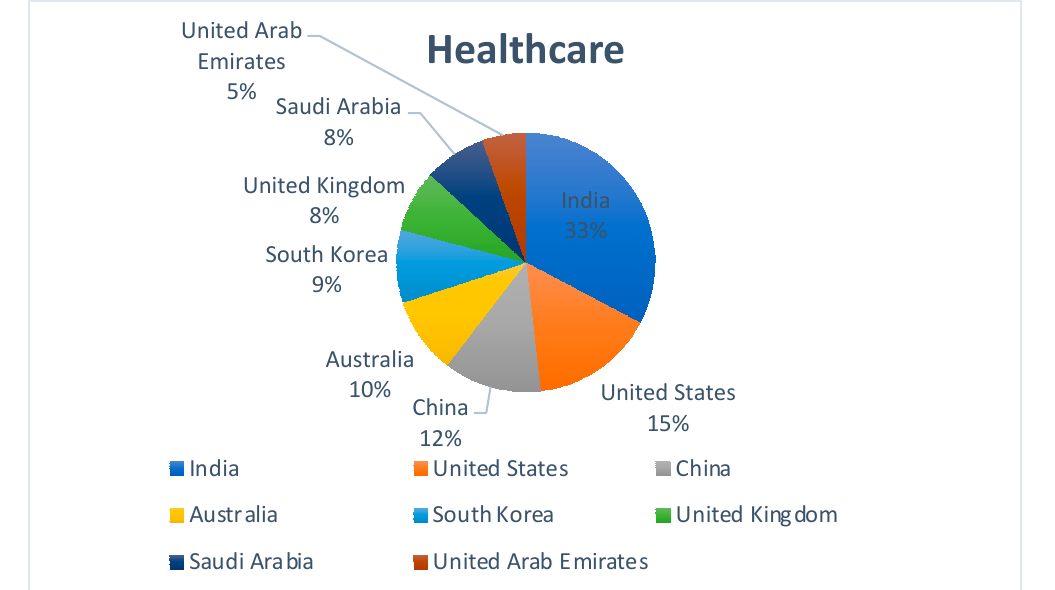
Figure 5. Region-specific publication distribution for Blockchain–Cloud and Healthcare.